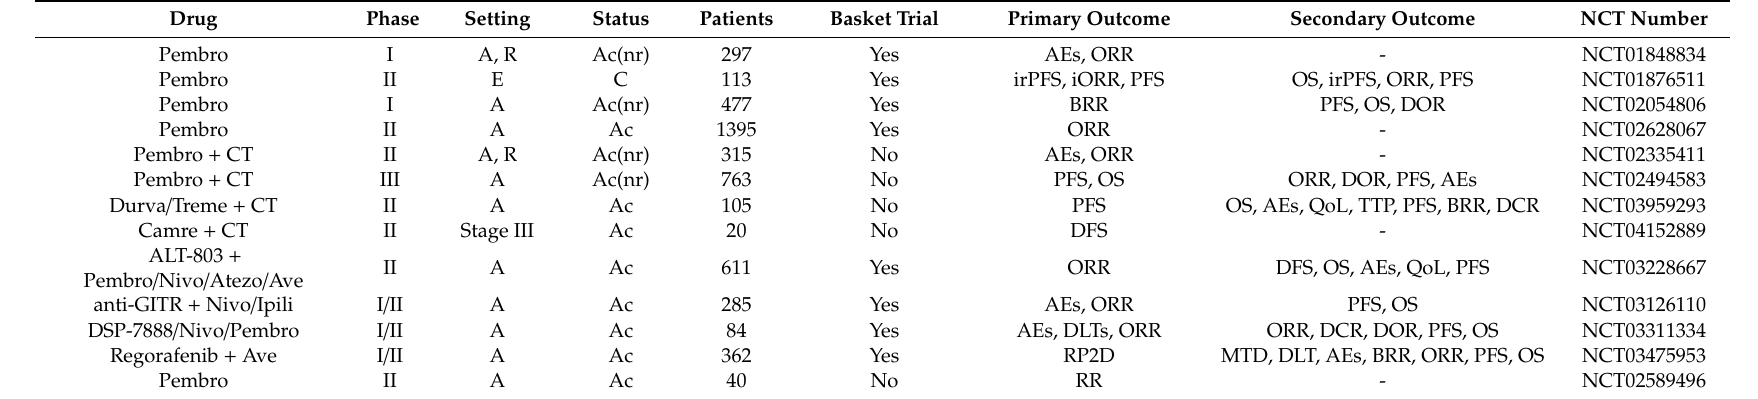
Table 2. Ongoing and recently completed clinical trials using immune checkpoint inhibitors (ICI) in GEC patients. Drug Phase Setting Status Patients Basket Trial Primary Outcome Secondary Outcome NCT Number Pembro I A, R Ac(nr) 297